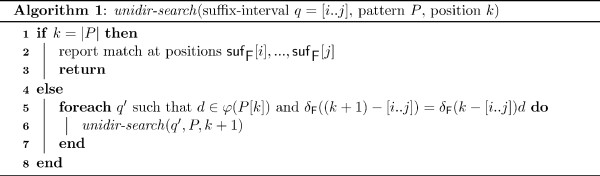
Unidirectional search algorithm for searching for a sequence pattern . Given the suffix array sufF of S, the procedure enumerates all occurrences of P in S when called by unidir-search([0..|S|], P, 0). In line 5, the suffix-interval q' is located by binary search in .